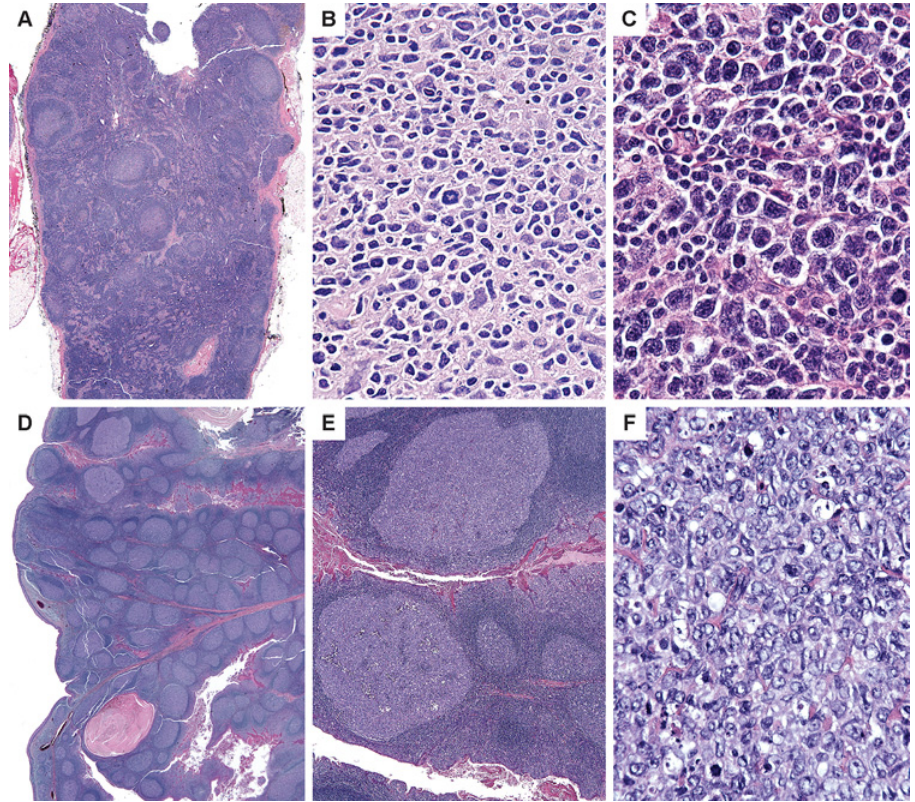
Fig 1. Morphology of isolated atypical follicles. An axillary lymph node dissection in a 61 year-old woman with breast carcinoma (case 1) shows one lymph node with scattered follicles containing sheets of centroblasts (A). The involved follicles exhibit sheets of large atypical cells with highly pleomorphic nuclear outlines and atypical mitoses (B). An axillary lymph node from a 53-year old woman (case 2) shows highly atypical large cells occupying an involved follicle (C). Sections of tonsil in a 6-year old boy (case 5) demonstrate a background of reactive follicular hyperplasia within which isolated follicles (upper left) show sheets of centroblasts (E and